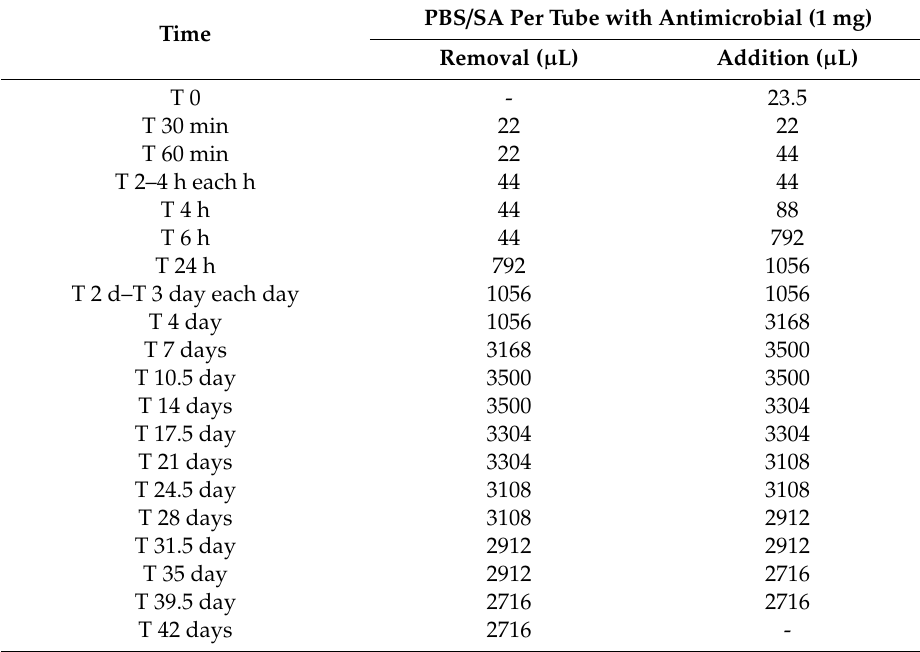
Table 1. Scheme of pipetting to simulate the gingival flow.